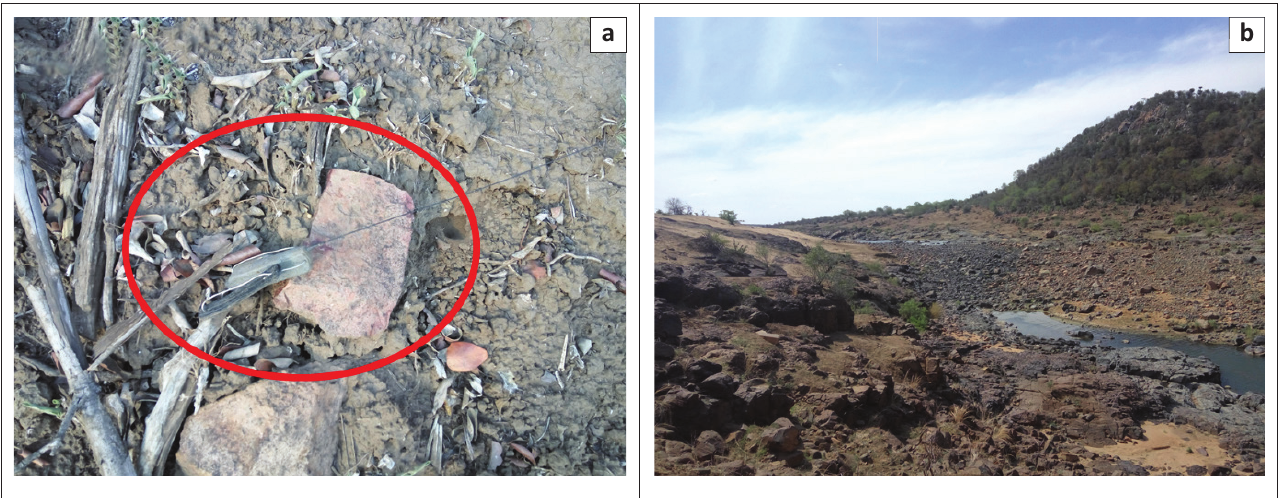
FIGURE 7: These photographs depict (a) the recovered telemetry tag (Tag32: HVIT2) as found by researchers (circled) and (b) no flow on the Letaba River downstream of Engelhardt Weir during the telemeter tag recovery survey.